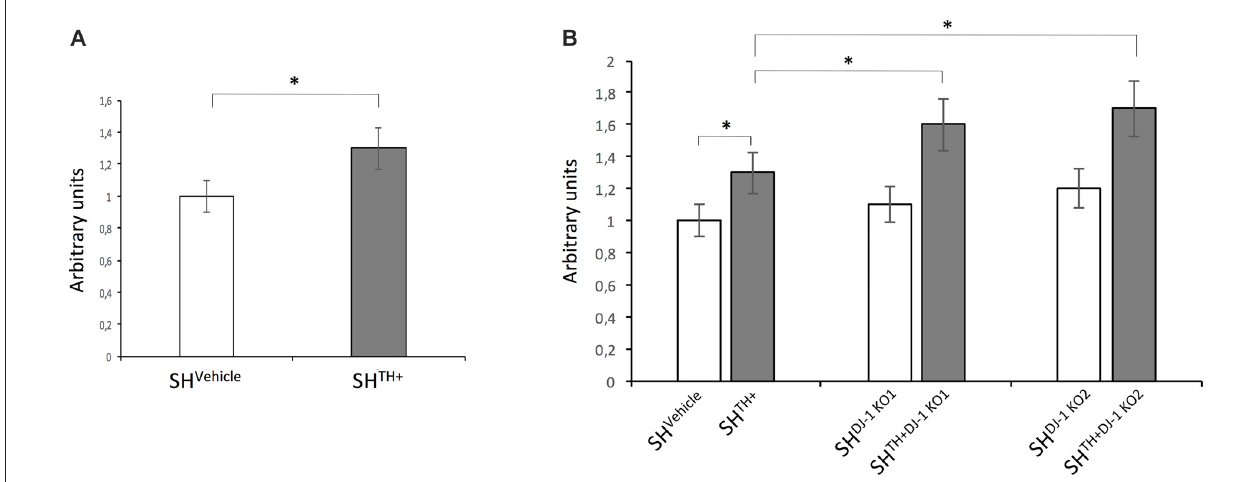
FIGURE 4 | Loss of DJ-1 increases levels of oxidative stress in dopaminergic SH-SY5Y cells. (A) Levels of reactive oxygen species (ROS) in the SH-SY5Ycells stably expressing the empty-IRES-Puromycin cassette (SH Vehicle ) and dopaminergic SH-SY5Y cells (SH TH + ). (B) Levels of ROS were compared between DA-free SH Vehicle and dopaminergic SH TH + cells containing wildtype DJ-1 and DA-free (SH DJ - 1 KO1 and SH DJ - 1 KO2 ) and dopaminergic (SH TH + DJ - 1 KO1 , and SH TH + DJ - 1 KO2 ) DJ-1 knockout cells. Levels of ROS in SH Vehicle were set to 1. ∗ p <